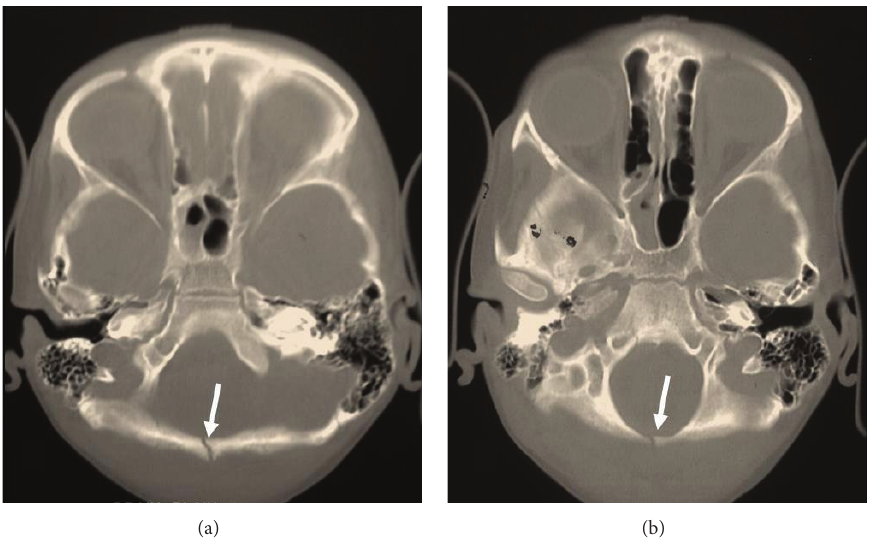
Figure 1: Axial MDCT bone window showing linear undisplaced fracture of occipital bone at the age of 12 years (arrows).